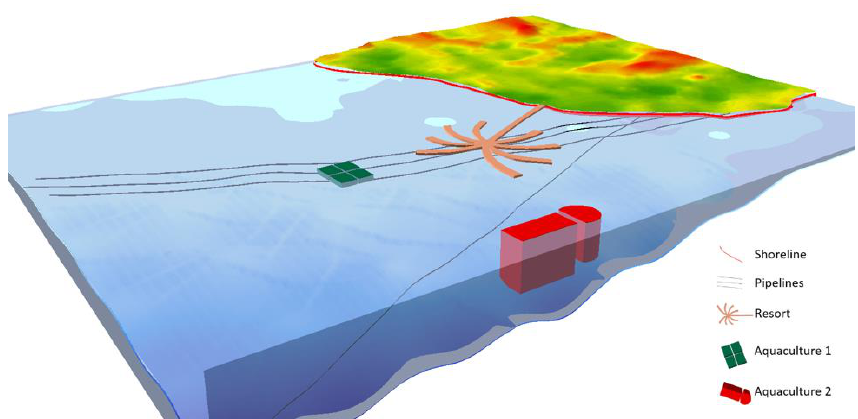
Figure 4. 3D representation of the registered legal objects in the database